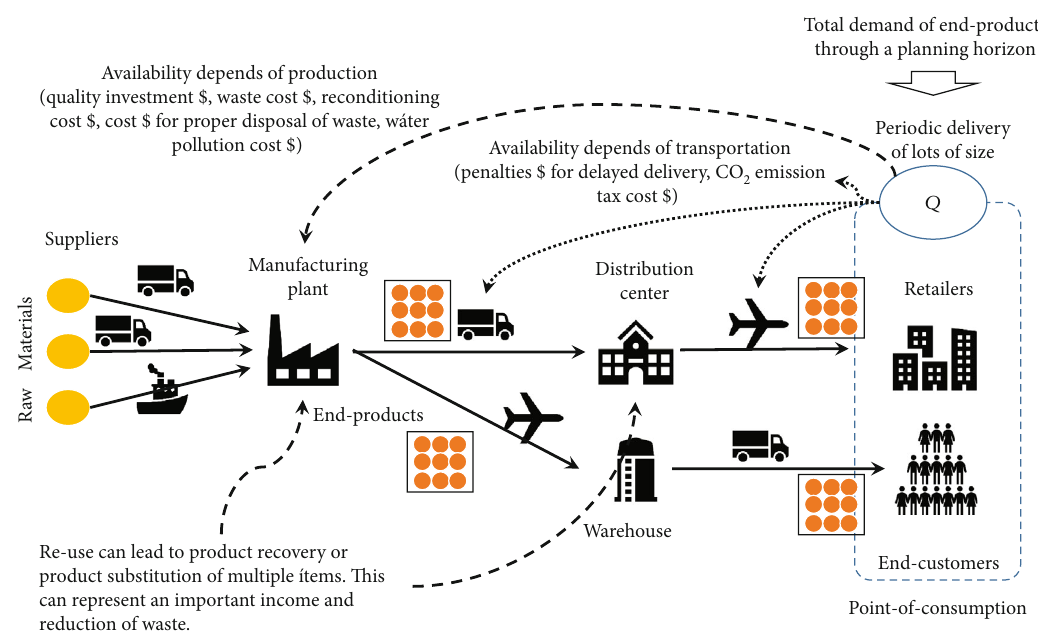
Figure 3: Economic aspects of the SC associated to inventory control.